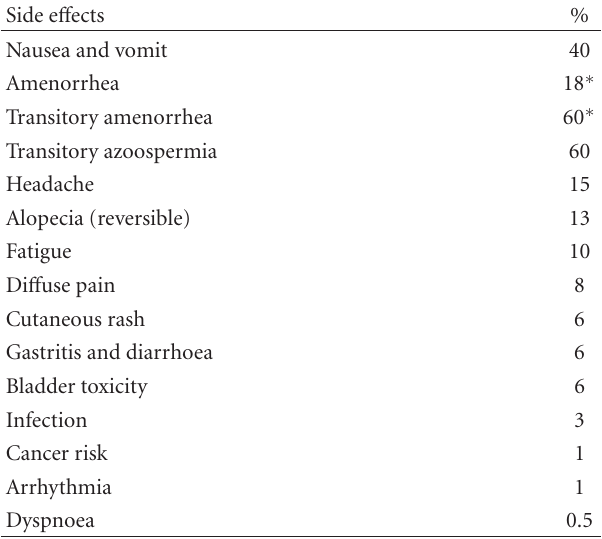
Table 3: Data obtained from 200 MS patients treated with cy in our centre over a ten-year period. ∗ of the fertile